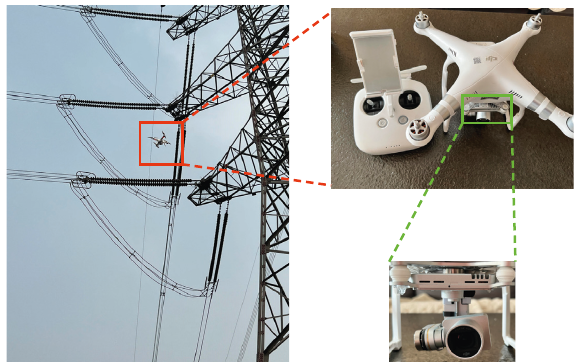
Figure 5: Data acquisition